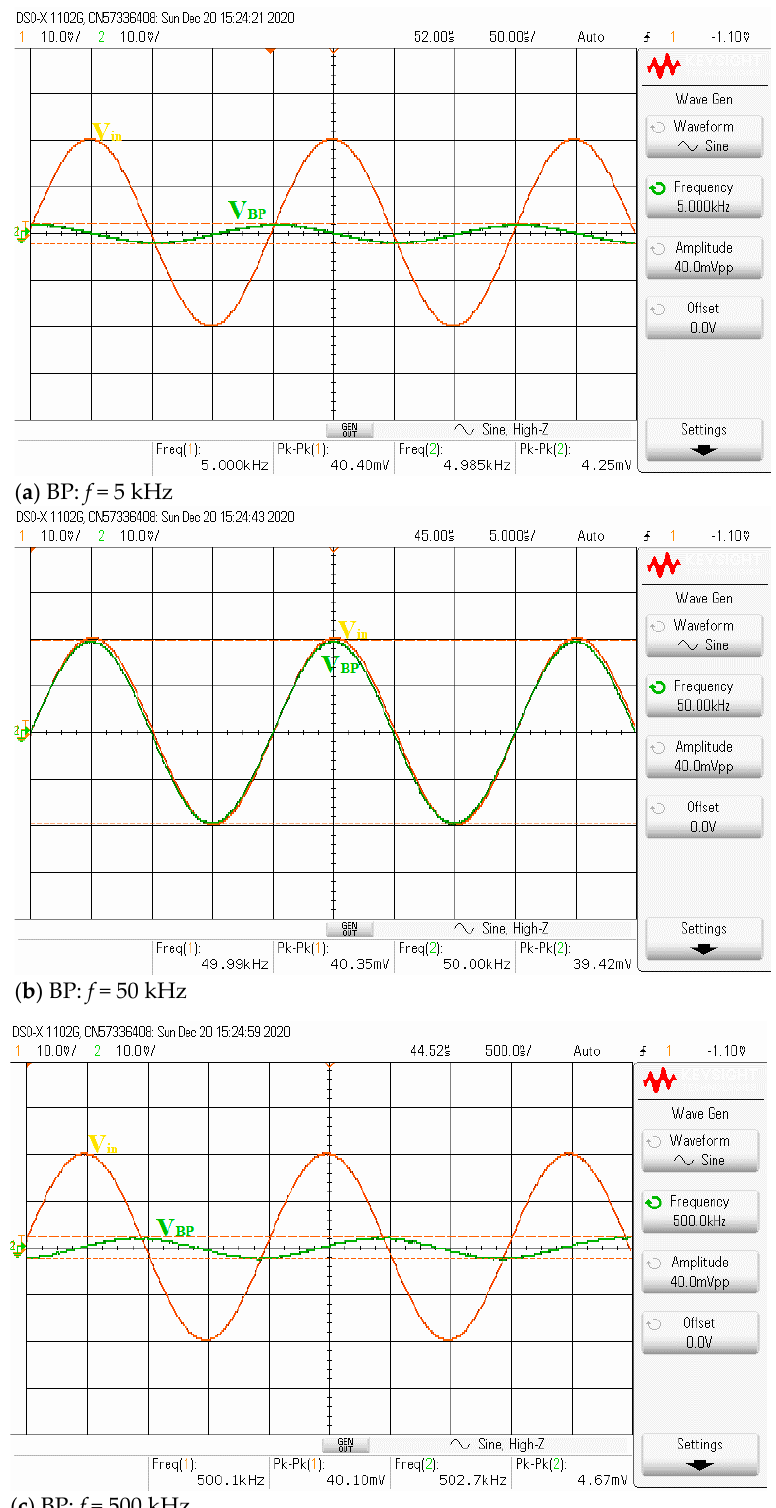
Figure 23. Measured BP filtering transient response.